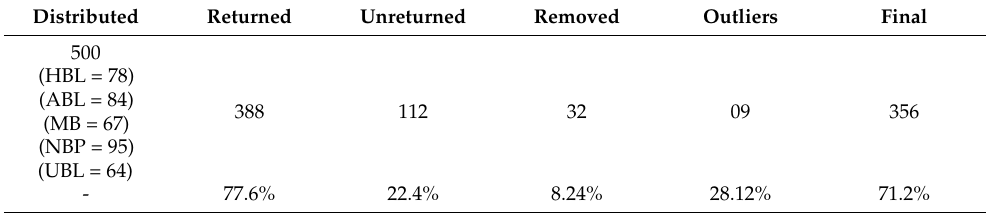
Table 1. Data cleaning, outliers, and response rate.